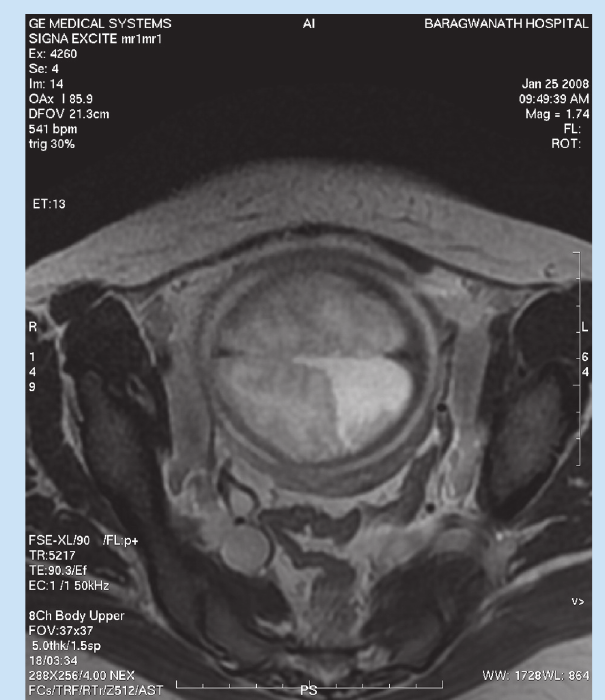
Fig. 1. Axial T2W image demonstrating a hyperintense CSF-filled cleft which is lined by grey matter and extends from the pial surface to the lateral ventricle, in keeping with an open lip schizencephaly.